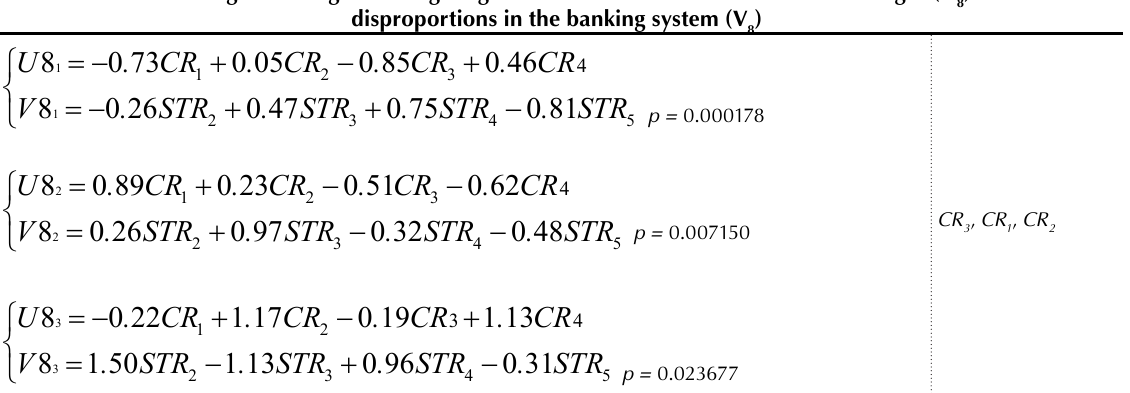
) and the state of the bank lending to the economy (V 7